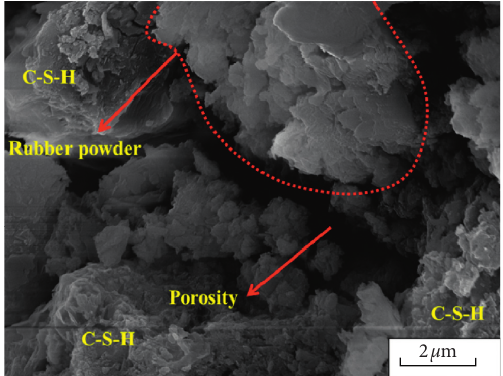
Figure 16: Interface between rubber powder and cement slurry.